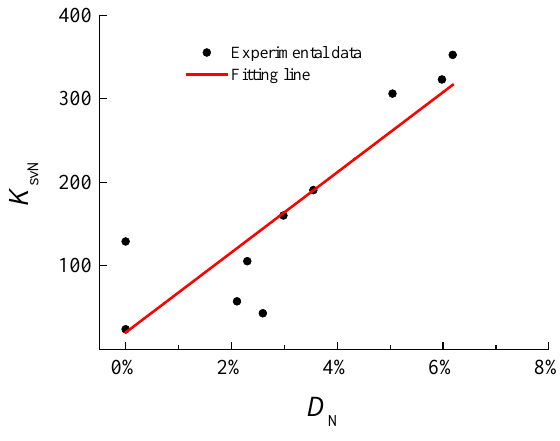
Figure 10. Relationship between K svN and D N .